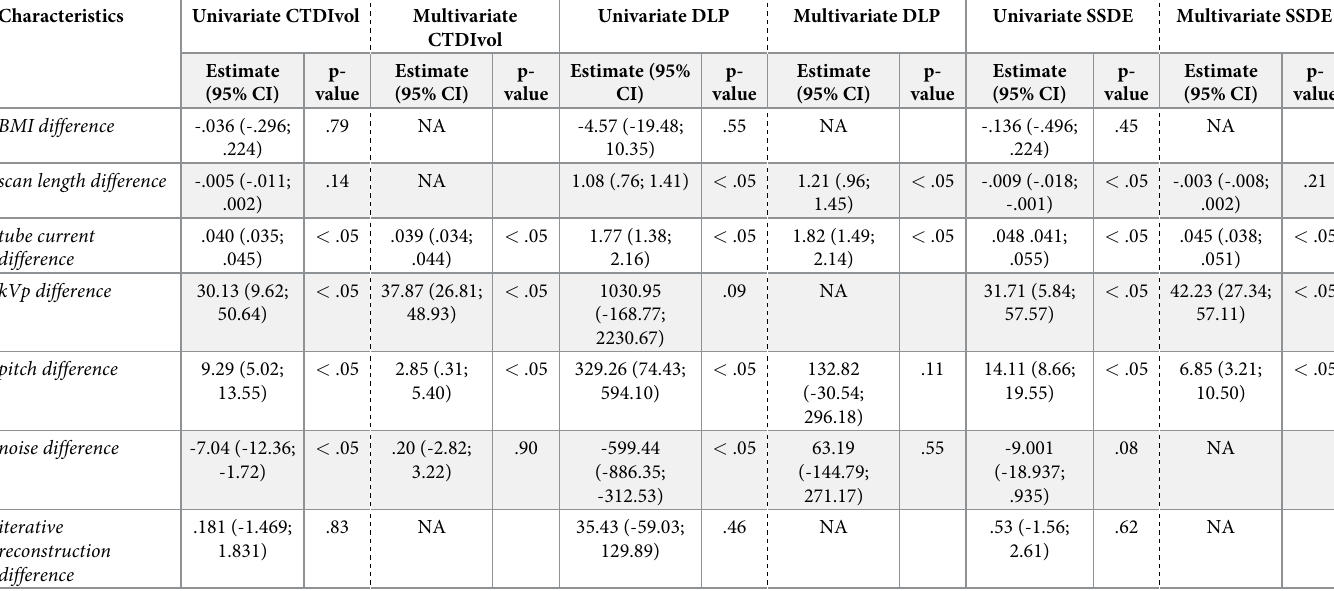
Table 3. Results of intraindividual analysis for CT scans of the abdomen and pelvis for the dose estimate parameter CTDIvol, DLP and SSDE. Characteristics